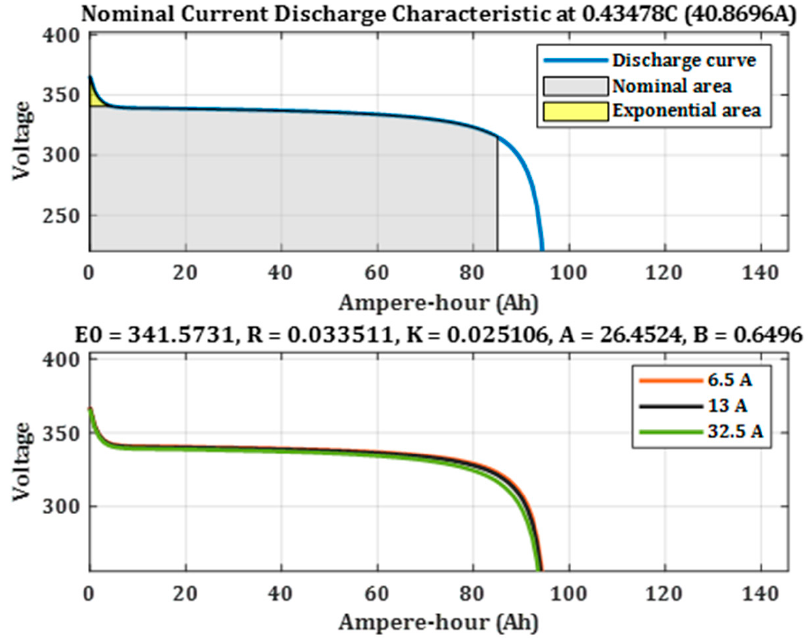
Figure 28. Nominal current discharge characteristics voltage (V) versus ampere-hour (Ah).